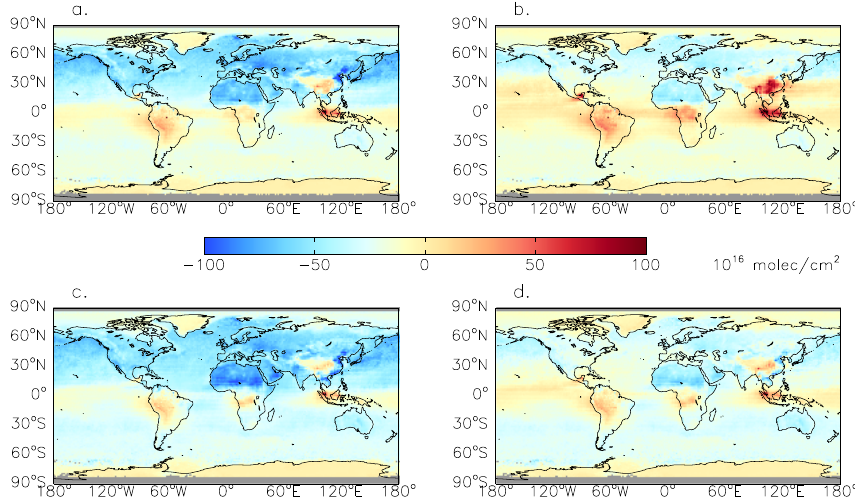
Figure 7. March through May difference between the simulated CO columns and MOPITT averaged over 2000–2009 for the (a) RefGMI, (b) GMI-HiEmis, (c) RefCOonly, and (d) COonlyLowNHOH simulations. The simulated CO is convolved with the MOPITT averaging kernels and a priori. Table 3. CO emission adjustment for the high-emission simulation compared to the standard